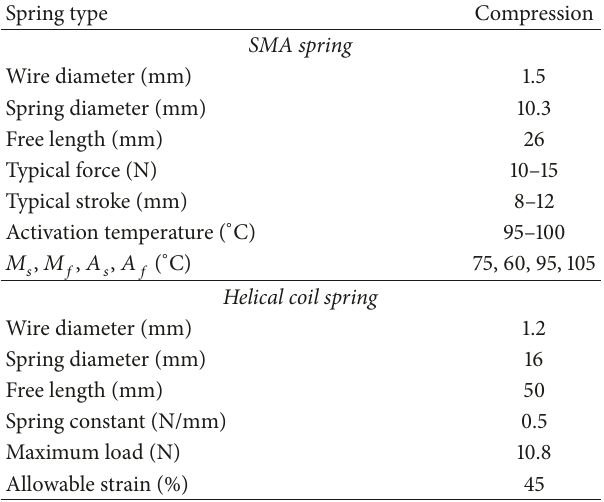
Table 2: Specifications of the SMA spring and helical coil spring ( 𝑀 𝑠 : martensite start temperature, 𝑀 𝑓 : martensite finish temper- ature, 𝐴 𝑠 : austenite start temperature, and 𝐴 𝑓 austenite finish